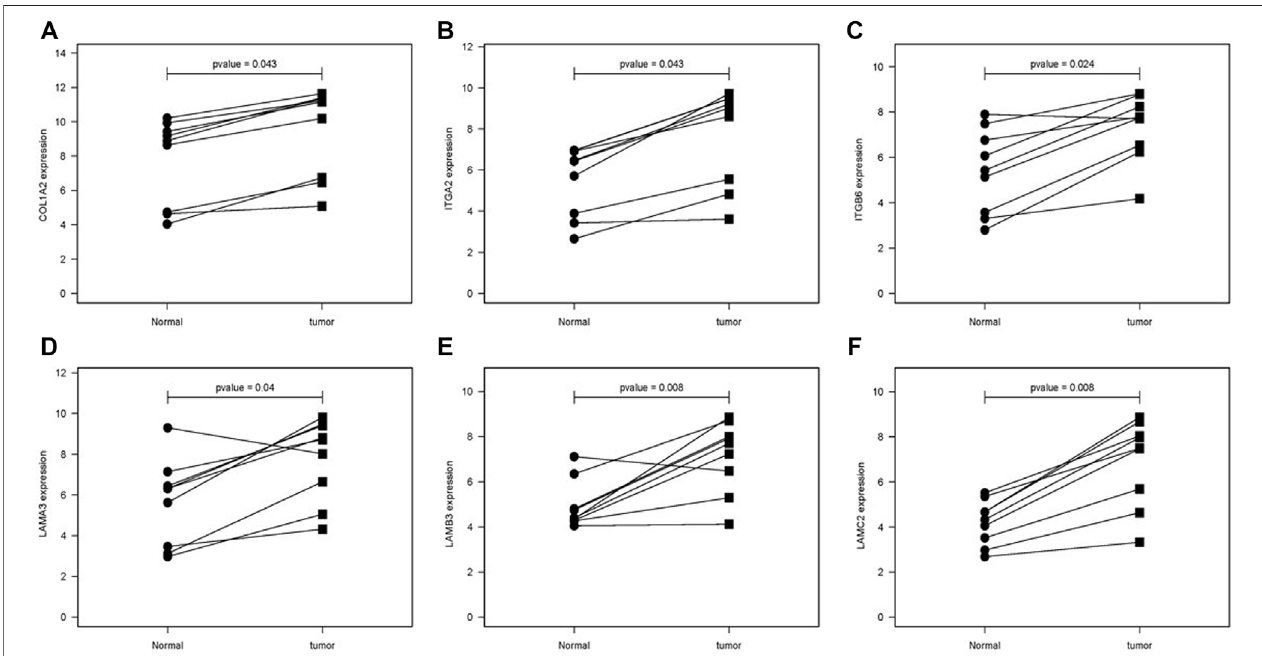
FIGURE 5 | Comparison of the hub gene mRNA levels in paired adjacent normal tissues and PAAD tissues from the GEO database. (A) COL1A2, (B) ITGA2, (C) ITGB6, (D) LAMA3, (E) LAMB3, and (F) LAMC2. PAAD, pancreatic adenocarcinoma.